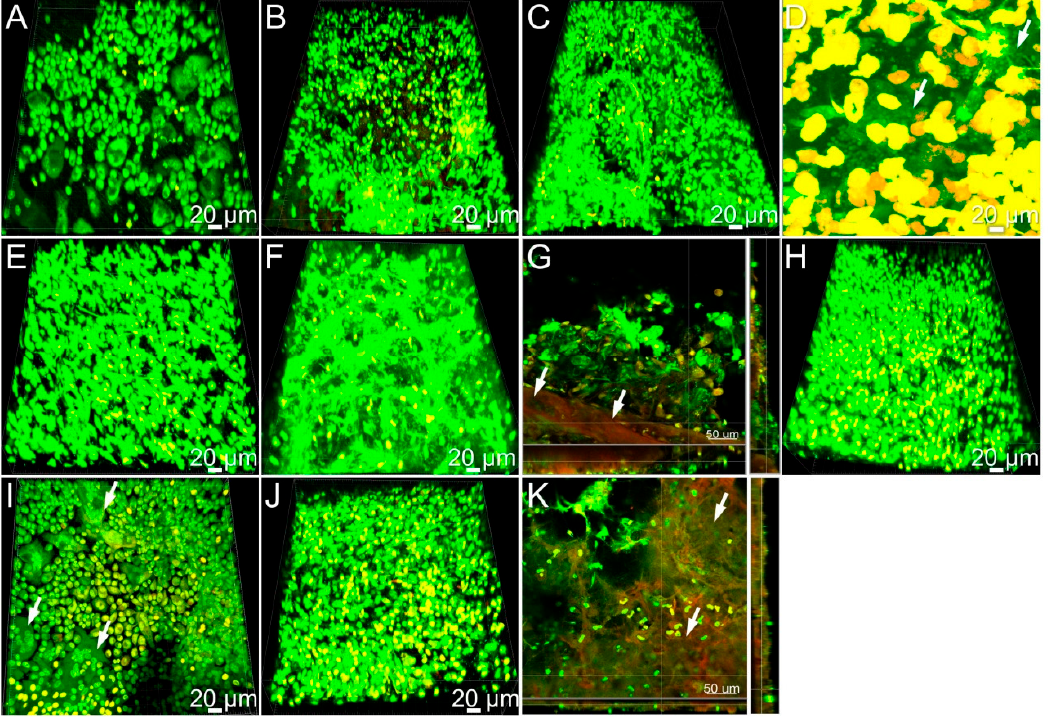
Figure 5. Bacterial infections promote accumulation of inflammatory cells in the implant-tissue interfaces. Confocal microscopic images of sterile titanium implants 21 days after implantation ( A ), S. oralis infected titanium implant surfaces ( B ), A. actinomycetemcomitans infected titanium implant surfaces ( C ), A. actinomycetemcomitans biofilms in the infected peri-implant tissues ( D , white arrow), P. gingivalis infected titanium implant surfaces ( E ), T. denticola infected implant surfaces ( F ), fine fibrillary material interposed between the implant surface and the connective tissue ( G , white arrows). S. oralis-P. gingivalis infected implants ( H , I ), A. actinomycetemcomitans-T. denticola infected implant surfaces ( J ). Thick layer of connective tissue ( K , white